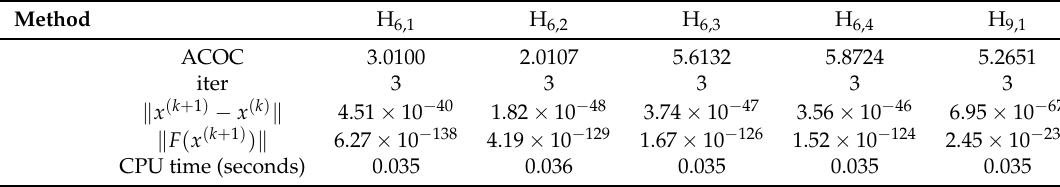
Table 3. Numerical results for elliptic partial differential equation.